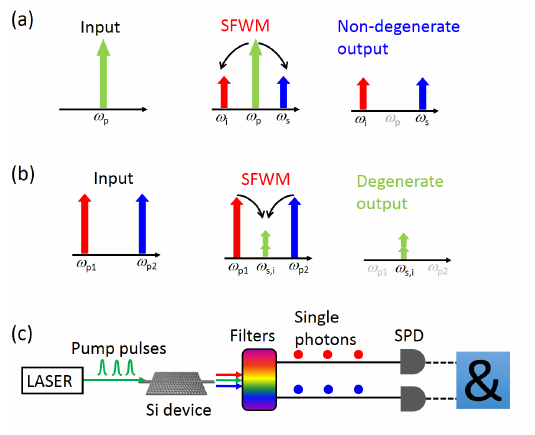
Fig. 3. Frequency (a) nondegenerate- and (b) degenerate-correlated photon-pair generation via SFWM for single-photon sources. (c) Diagram of an experimental setup for generating single photons from a silicon device via frequency non-degenerate SFWM. Dashed lines denote electronic